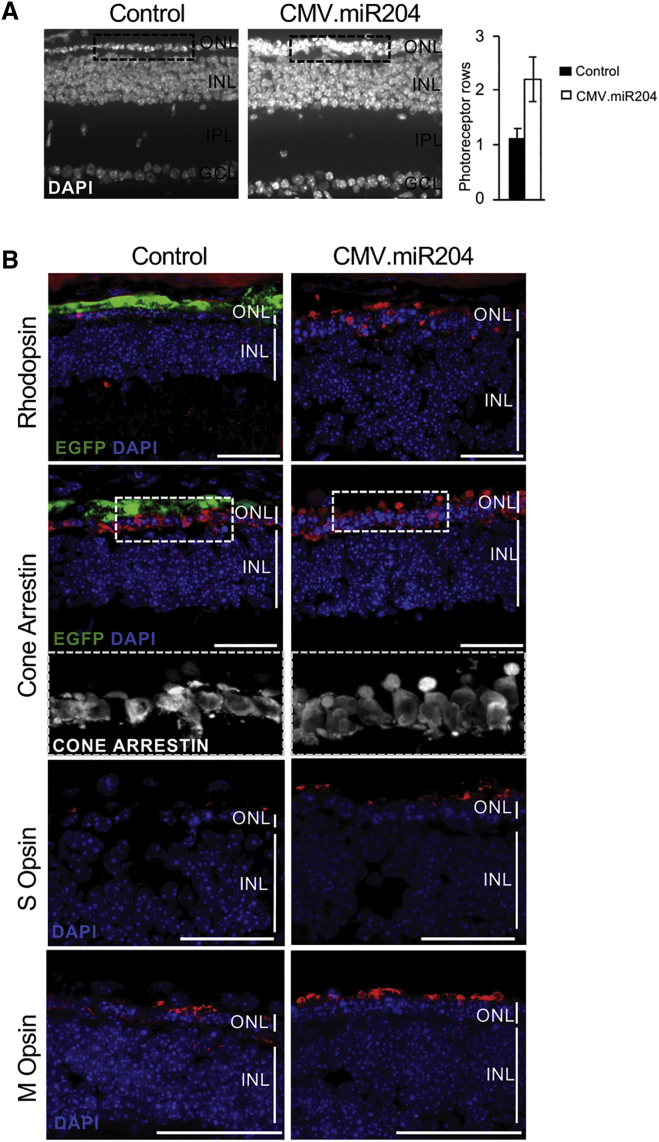
AAV-Delivered miR-204 at PN4 Increases Photoreceptor Survival in the Aipl1−/− Mouse(A) Nuclei staining (DAPI) of Aipl1−/− retinal sections at PN21 following subretinal delivery of miR-204 at PN4. Almost invariably, only one row of nuclei is present in the ONL of Aipl1−/− eyes injected with the control CMV.EGFP vector (left dashed box inset). There is an increase in the number of rows and density of nuclei at the ONL of the contralateral eye injected with the AAV.CMV.miR204 vector mix (right dashed box inset). The other retinal layers (INL, IPL, and GCL) appear to be unaffected. Plot shows the average number of photoreceptor nuclei rows in miR204-treated eyes compared to contralateral eyes injected with the control vector (n = 11; error bars are SEM; p = 0.06). (B) Confocal microscopy images of immunolabeling for rod (Rhodopsin; in red) and cone photoreceptor markers (Cone Arrestin, M Opsin, S Opsin; in red) on retinal sections at PN21. Control virus distribution is shown by the EGFP fluorescence (green). DAPI nuclei counterstaining is shown in blue. An increased staining for photoreceptor markers is observed at the ONL of eyes injected with the AAV.CMV.miR204 vector mix compared to contralateral control (CMV.EGFP)-treated eyes. Dashed box insets: close-up of the staining for cone arrestin in the framed area. Viral doses were the following: 1 × 109 GC AAV.CMV.miR204/1 × 108 GC AAV.CMV.EGFP per eye and 1.1 × 109 GC AAV.CMV.EGFP per eye). GCL, ganglion cell layer; INL, inner nuclear layer; IPL, inner plexiform layer; ONL, outer nuclear layer. Scale bars: 50 μm.